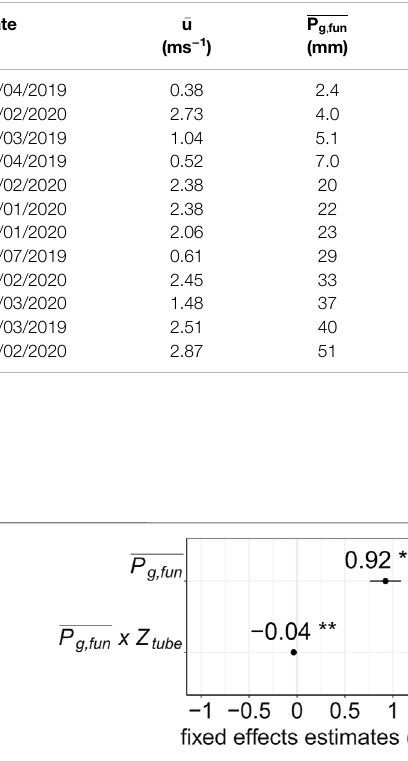
TABLE 3 | Overview of the sampled gross precipitation and wind conditions during the uncovered period ordered according to the cumulated events size. Weeks without rain are not listed. Variables shown are: recorded weekly average of wind speed ( (cid:1) u ), manually sampled weekly average cumulative funnel precipitation at 1.5 m above ground ( P g , fun ), manually sampled weekly average cumulative tube precipitation at ground level ( P g , tube ), and the splash loss corrected interception tubes measurements ( P g , tube , cor ) along with the coef fi cient of quartile variation (CQV) of precipitation measurements.